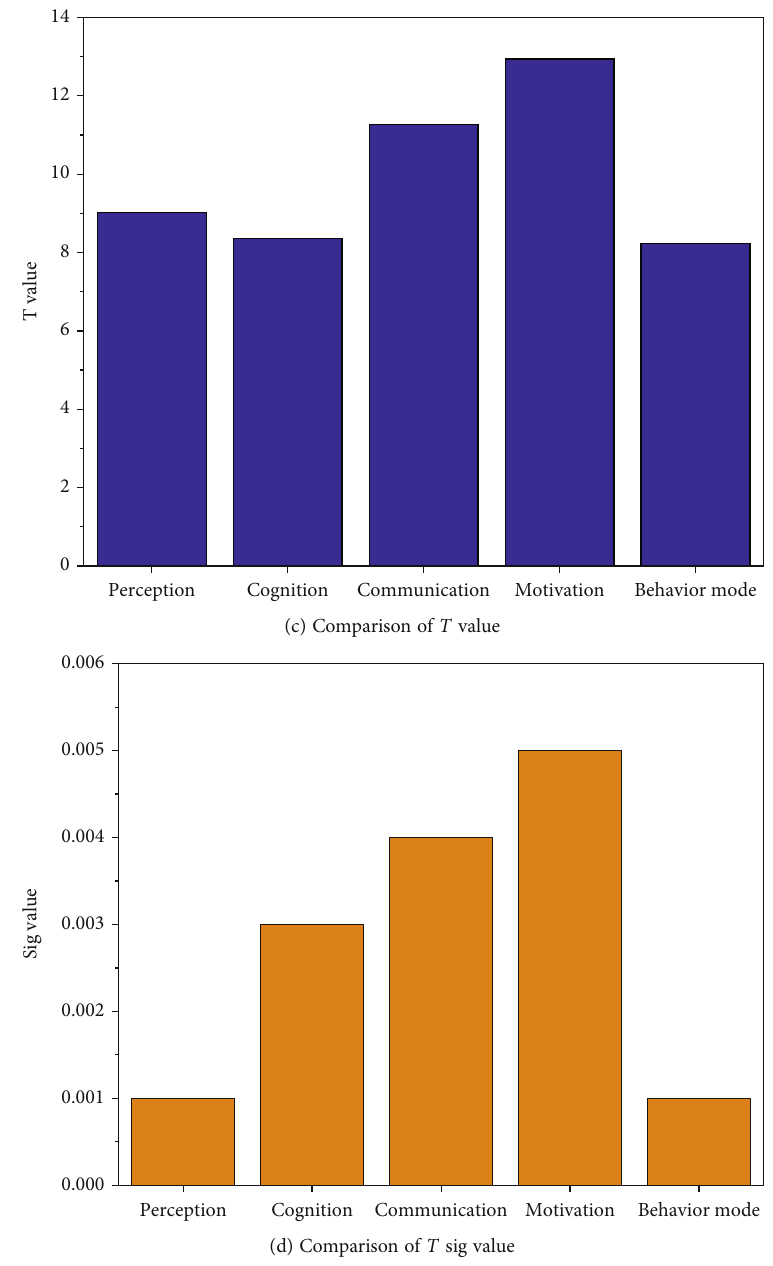
Figure 6: Comparison of pretest di ff erences of SRS scale between the experimental group and control